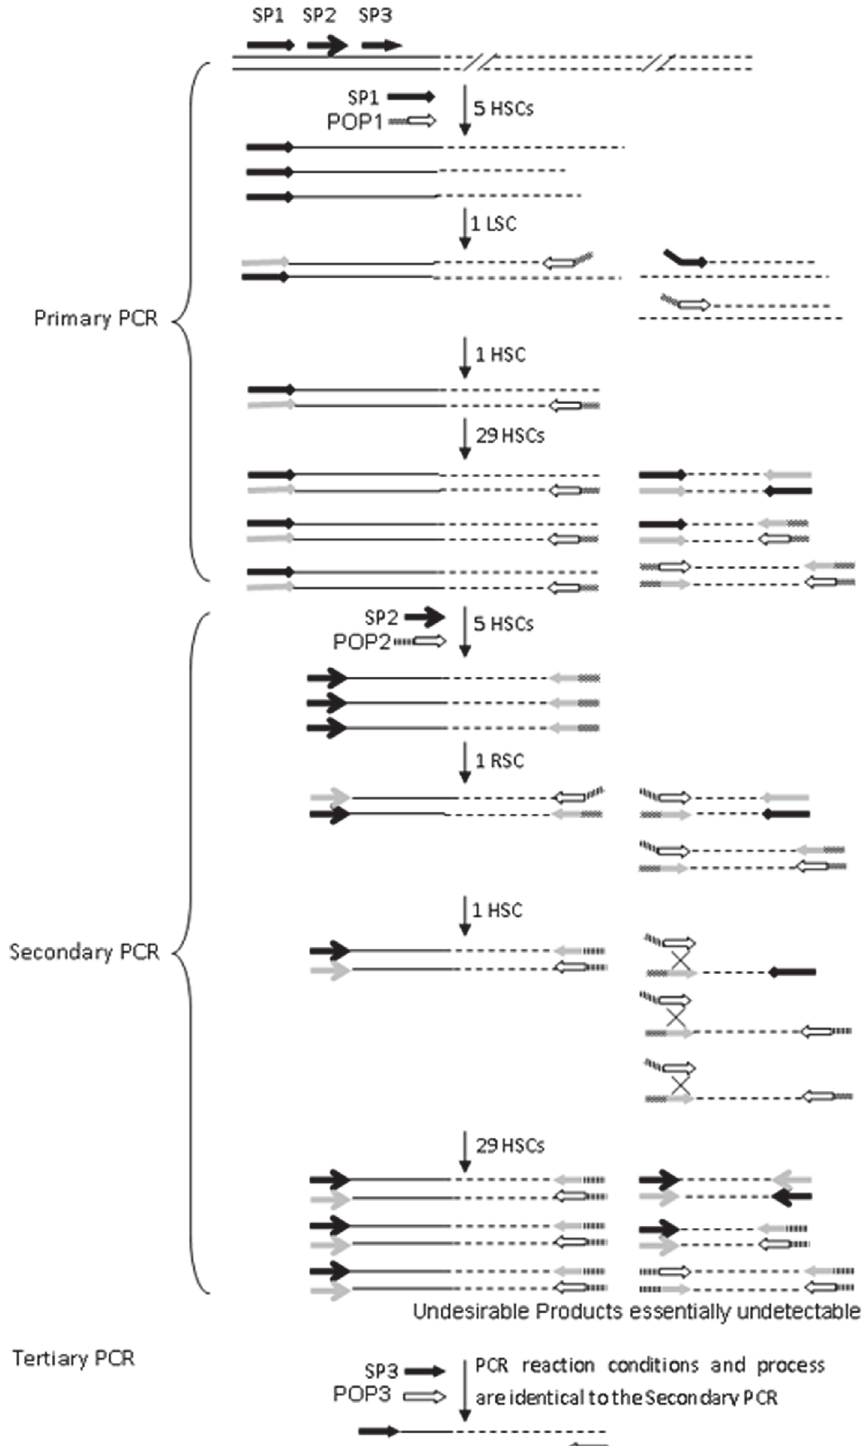
Fig 1. Overview of primer partially overlapping-based PCR. The first five high-stringency cycles (HSC) of each PCR are to increase copies of the single-stranded DNA of interest. The one low-stringency cycle (LSC) of primary PCR facilitates POP-P annealing to the target DNA and extension towards SP1. The one reduced- stringency cycle (RSC) of secondary PCR allowed POP-S to bind to the POP-P annealing site. A double- stranded target molecule was synthesized in the first HSC following LSC/RSC, and served as the